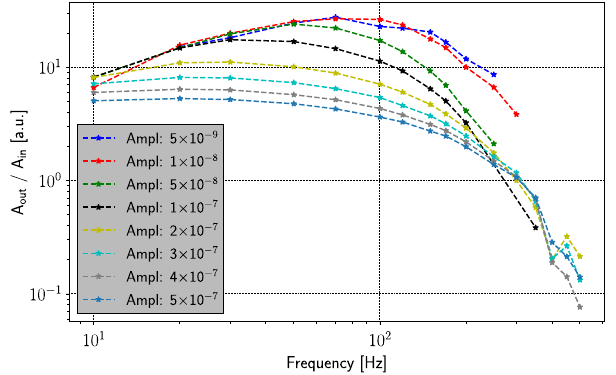
FIG. 7. Transfer functions for different sinusoidal ripple am- plitudes obtained from the tune-to-spill Henon map-based sim- ulation.